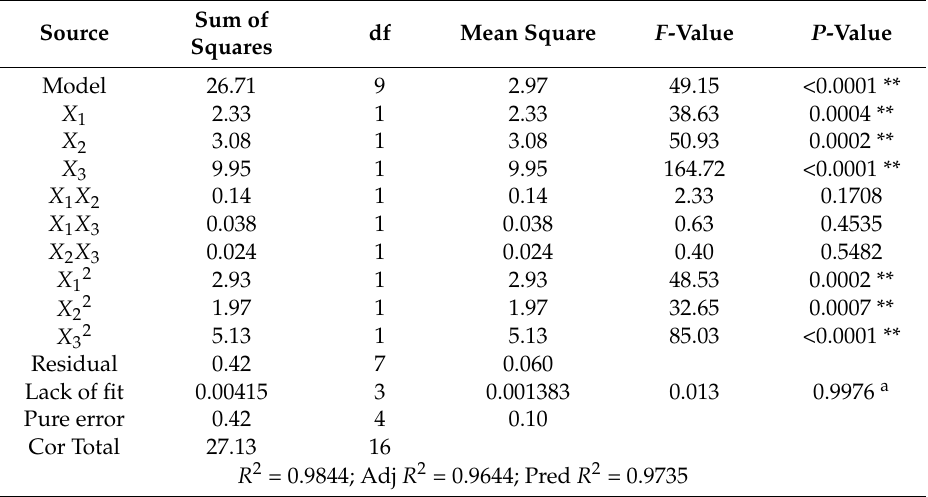
Table 3. ANOVA for response surface quadratic model of PPP